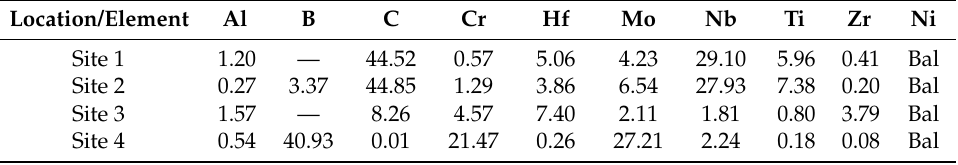
Table 2. Chemical compositions in at. % of solidification products displayed in Figure 3. Location/Element